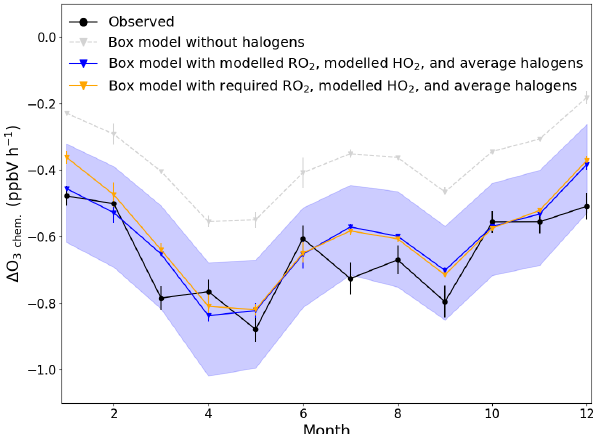
Figure 7. Average monthly (cid:49) O 3 due to chemical loss between 09:30 (09:00–10:00) and 17:30 (17:00–18:00)UTC for each month (black) compared to box-modelled (cid:49) O 3 due to chemical loss us- ing modelled RO 2 and HO 2 with (blue) and without (grey) halo- gen monoxides (BrO and IO), and using required RO 2 to get [NO 2 ] Obs . / [NO 2 ] PSS ext . = 1, modelled HO 2 , and the annually averaged halogen monoxides (orange). The error bars on the ob- served chemical loss is the standard error of all the days used for each month, and for the box model, it is the minimum and maximum (cid:49) O 3 modelled for each month. The blue shaded area shows the pos- sible variability in the chemical loss when including the measured halogens at the CVAO (BrO; 2 . 5 ± 1 . 1pptV, IO; 1 . 4 ± 0 . 8pptV) (Read et al.,